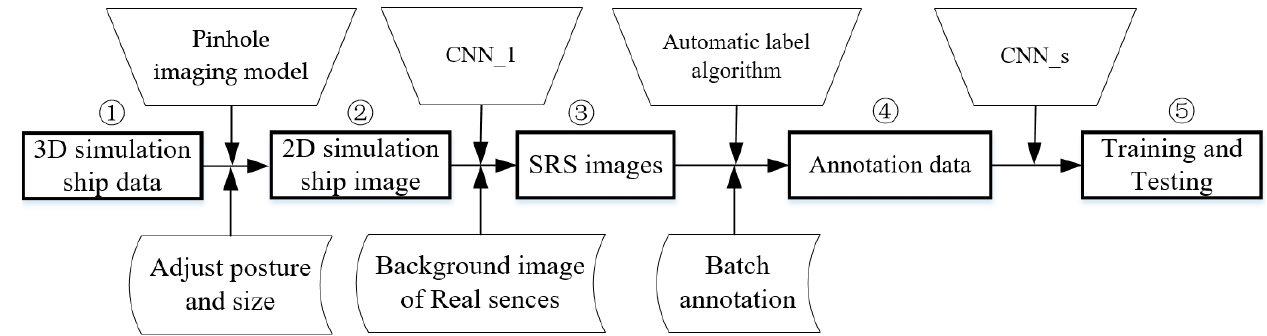
Figure 1. The main workflow of this paper. ① is made by the 3D simulation software, and ① is designed according to the appearance of the real ship in the real experiment scene. After adjusting the posture and the size of the 3D simulation ship data with the 3D simulation software, ① is projected onto the 2D plane through a pinhole imaging model, and ② is derived. Then, we superimpose the foreground target (2D ship), which is extracted from ② to the real scene background, so we obtain ③ , and we can also obtain ④ by the proposed method. The final task ⑤ is to train and test the SRS image with different CNN algorithms.